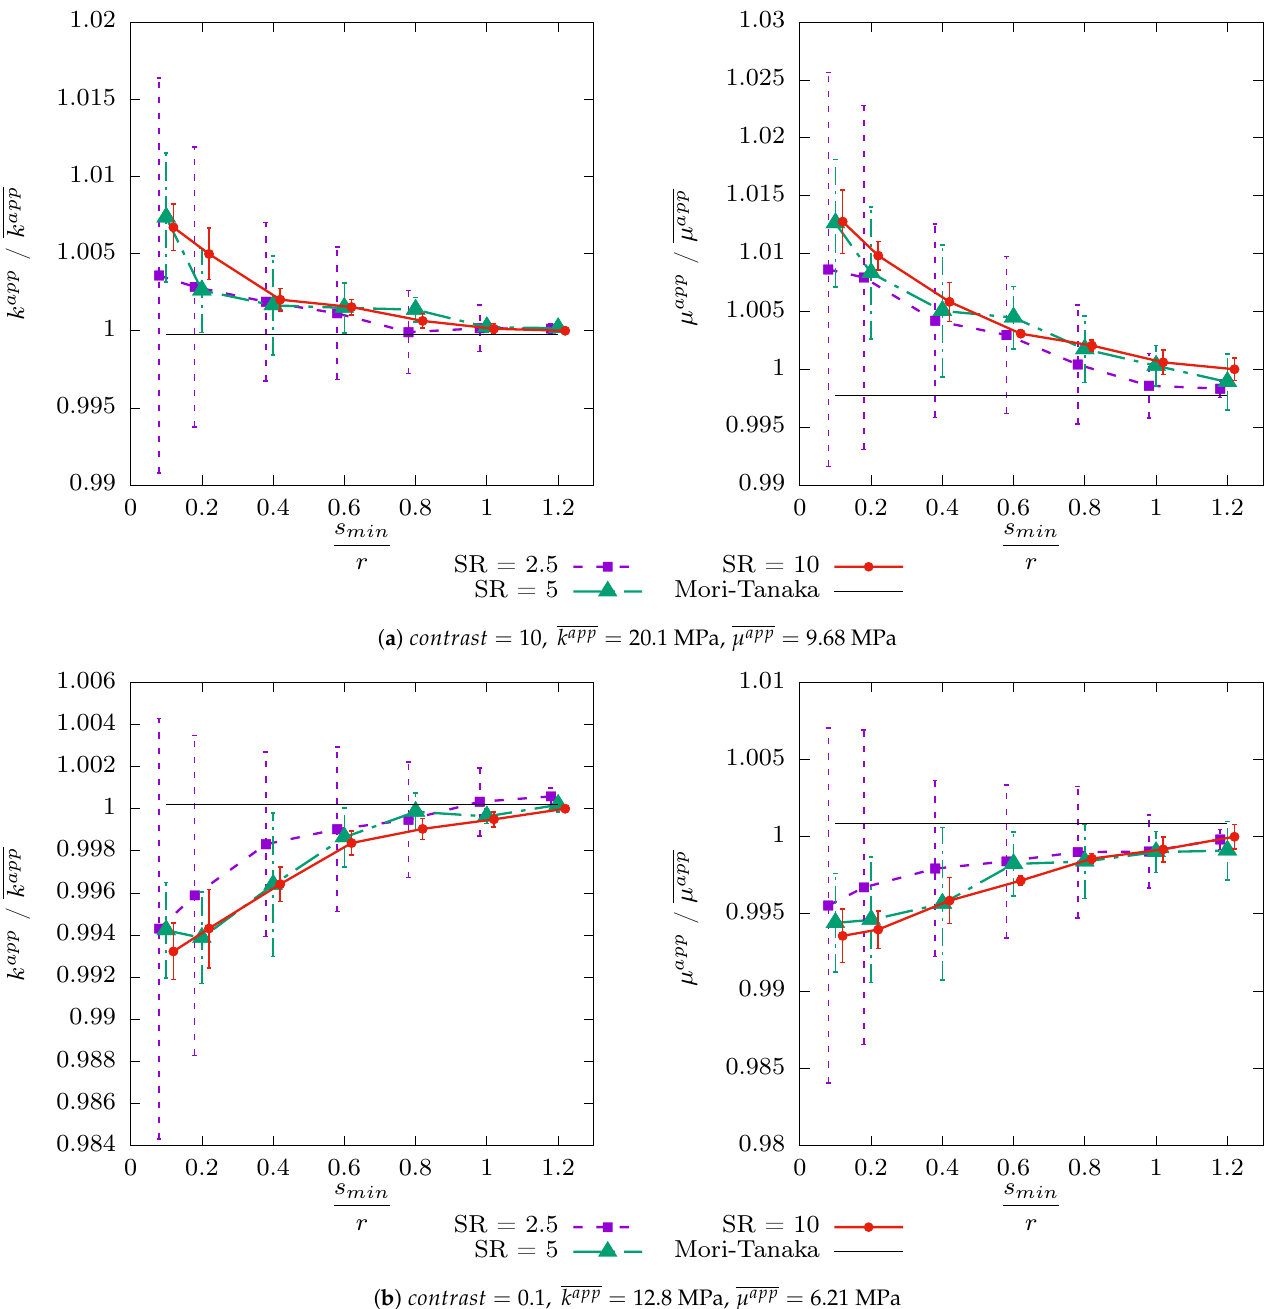
Figure A1. Mean values and standard deviations on the mean value for the apparent moduli as a function of the packing parameter s min / r ( r = 10 µ m) for a volume fraction of inclusions f v = 13.4 %. For clarity, the error bars and dots are slightly shifted around for each studied minimum